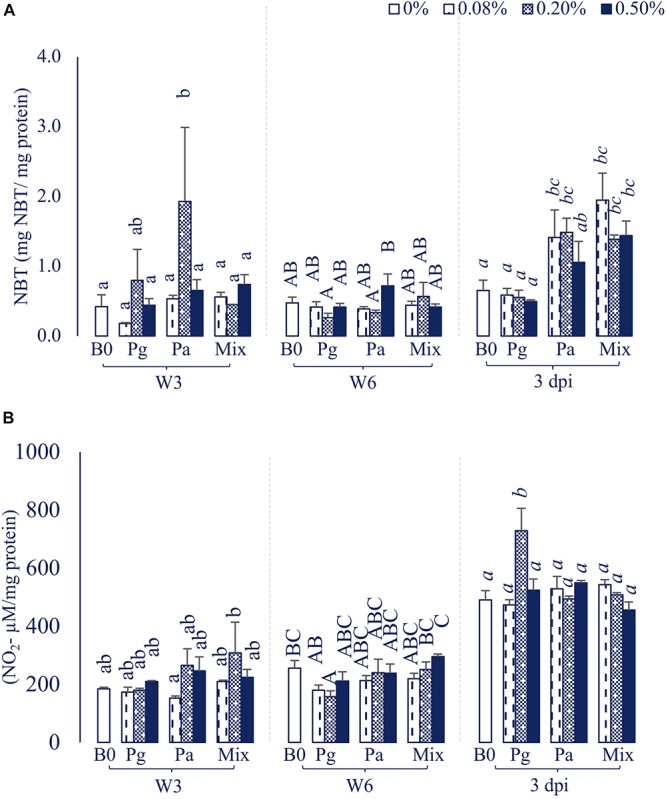
(A) Respiratory burst activity (RBA) and (B) Nitric oxide synthase (NOS) production activity in striped catfish fed extract-based diets containing a single supply or mixture of P. guajava and P. amarus at 0; 0.08; 0.2; and 0.5% after 3, 6 weeks and 3 dpi. B0, basal diet; Pg, P. guajava; Pa, P. amarus; Mix, Mixture of P. guajava and P. amarus; W3, week 3; W6, week 6; 3 dpi, 3 days post injection with E. ictaluri. Different letters indicate differences among diets at a given time point (p < 0.05). Values are means ± SEM, n = 3.